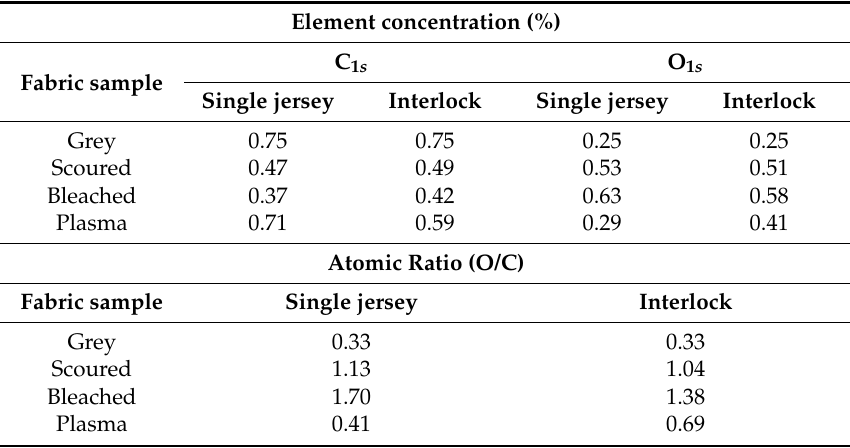
Table 7. Surface elemental analysis and atomic ratios of knitted fabrics (plasma condition: 150 W output power and 0.4 L/min flow